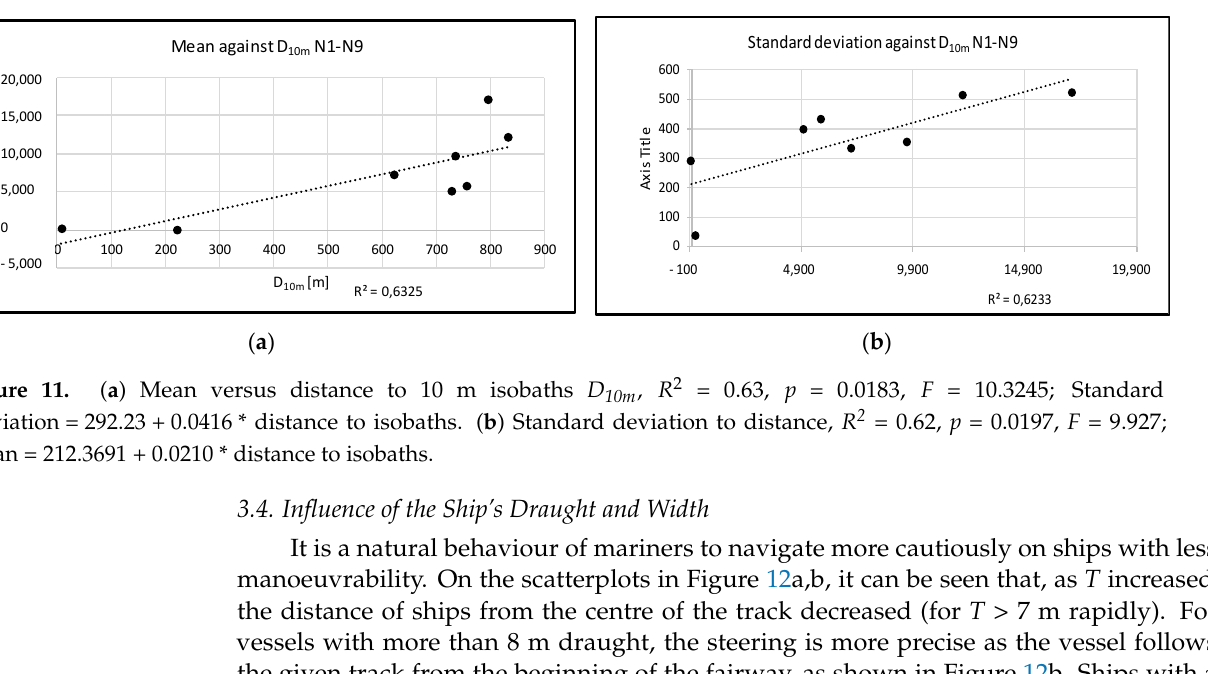
Scatterplot of Distance from center [m] against T[m]